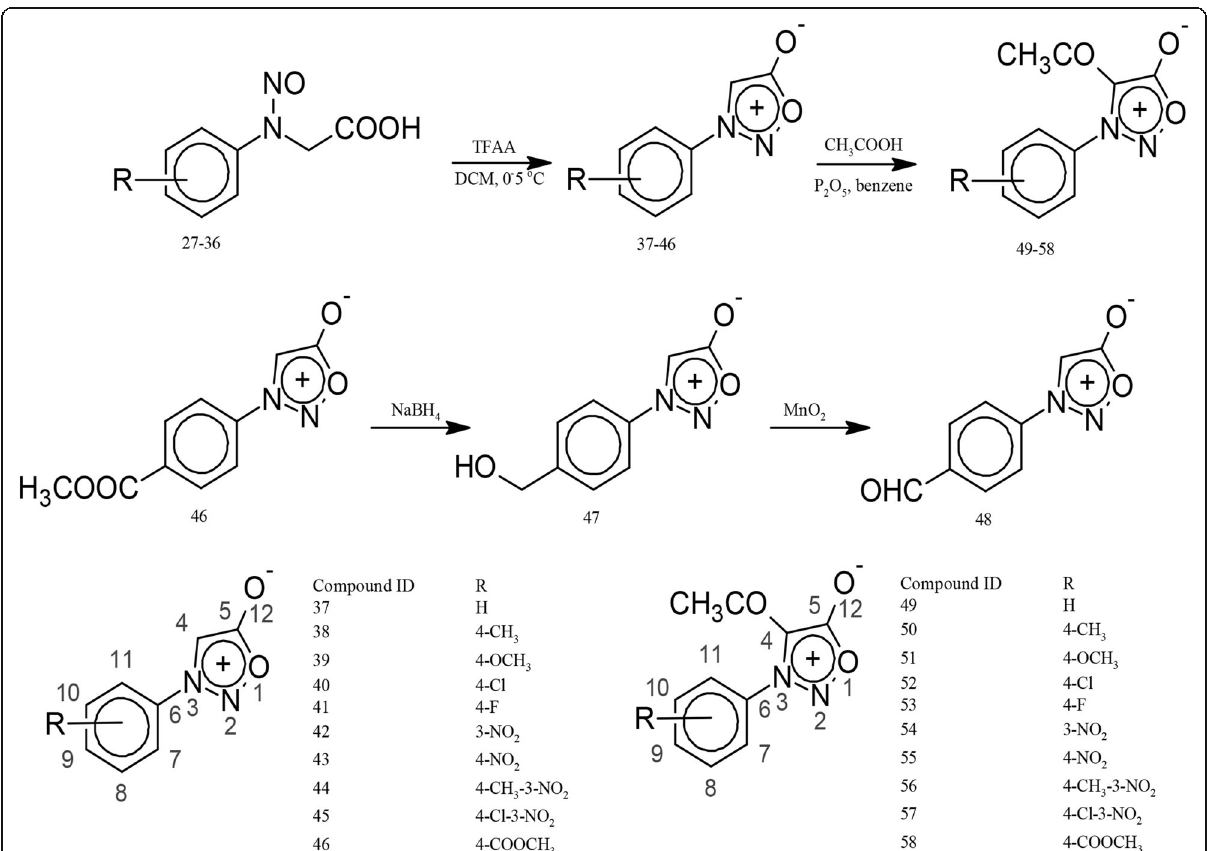
Fig. 3 Synthesis of 3-arylsydnone 37 - 46 , alcohol sydnone derivative 47 , aldehyde sydnone derivative 48 and 4-acetyl-3-arylsydnone analogues 49 –